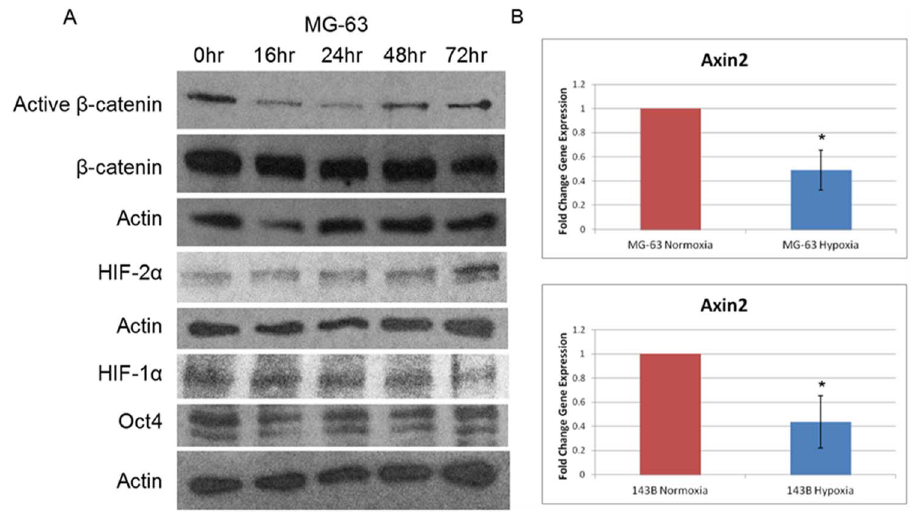
Figure 2. Hypoxia down-regulates Wnt/ b -catenin signaling in human OS cells. A, MG-63 human OS cells were cultured under hypoxia over 72 hour, and increased HIF protein expression was observed by western blot. Protein levels of active b -catenin were decreased under hypoxic conditions relative to normoxic conditions (0 hour). Actin was the loading control. B, Axin2 mRNA levels were determined as a measure of Wnt/ b - catenin signaling under hypoxic conditions (72 hour, 0.5% O 2 ) via quantitative reverse-transcription PCR (qrt-PCR) normalized to normoxia. Asterisks indicate statistical significance (*p , 0.05).